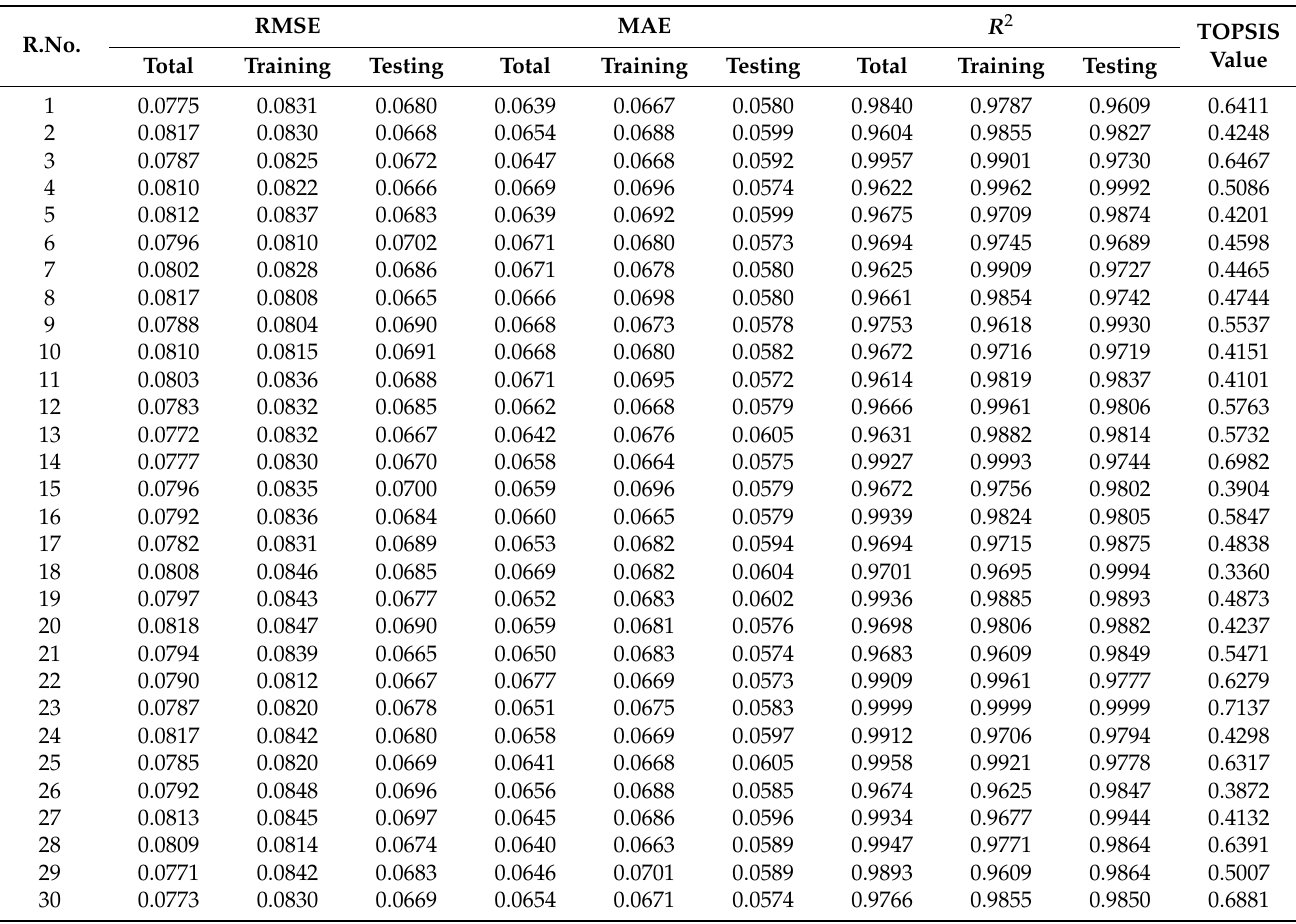
Table 8. Performance of SVR model for crack width (W) using MFO